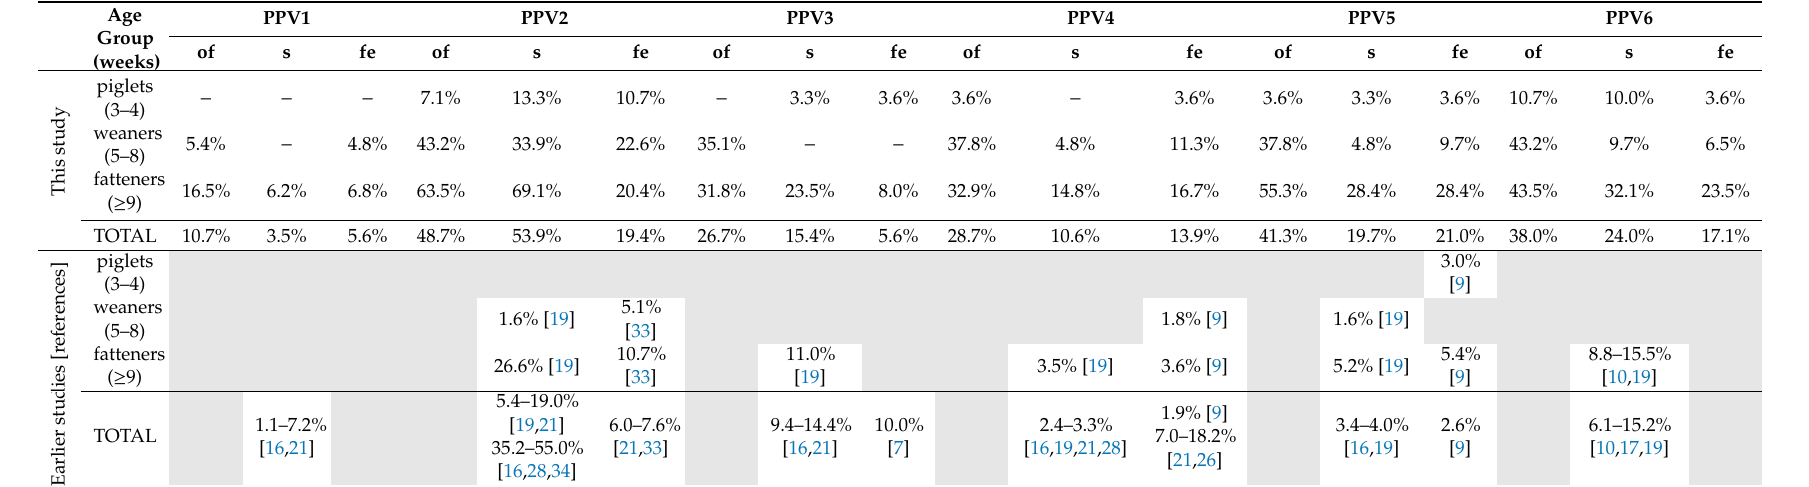
Table 2. Comparison of detection rates of porcine parvoviruses 1–6 (PPV1–PPV6), in di ff erent age groups of pigs (piglets, weaners, and fatteners) and di ff erent materials (of—oral fluid, s—serum, and fe—feces), between this study and earlier reports. Cells marked with “–“ indicate negative results. Light-gray shaded cells correspond to lacking